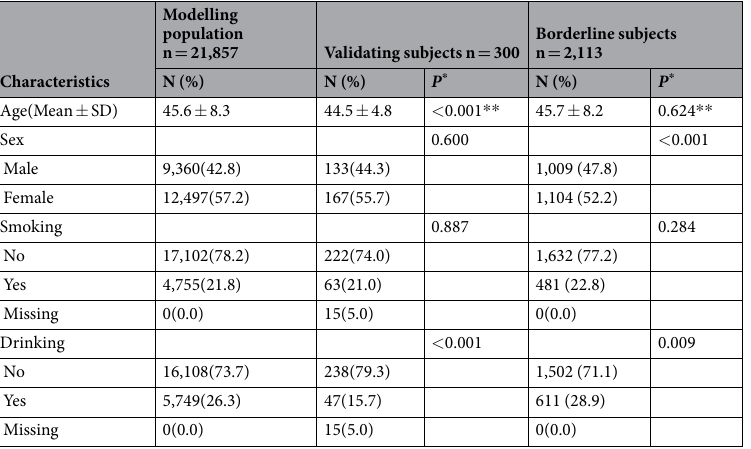
Table 1. Baseline characteristics of participants in different study populations. * Pearson’s χ 2 test compared to the modelling population without missing values. ** Student’s